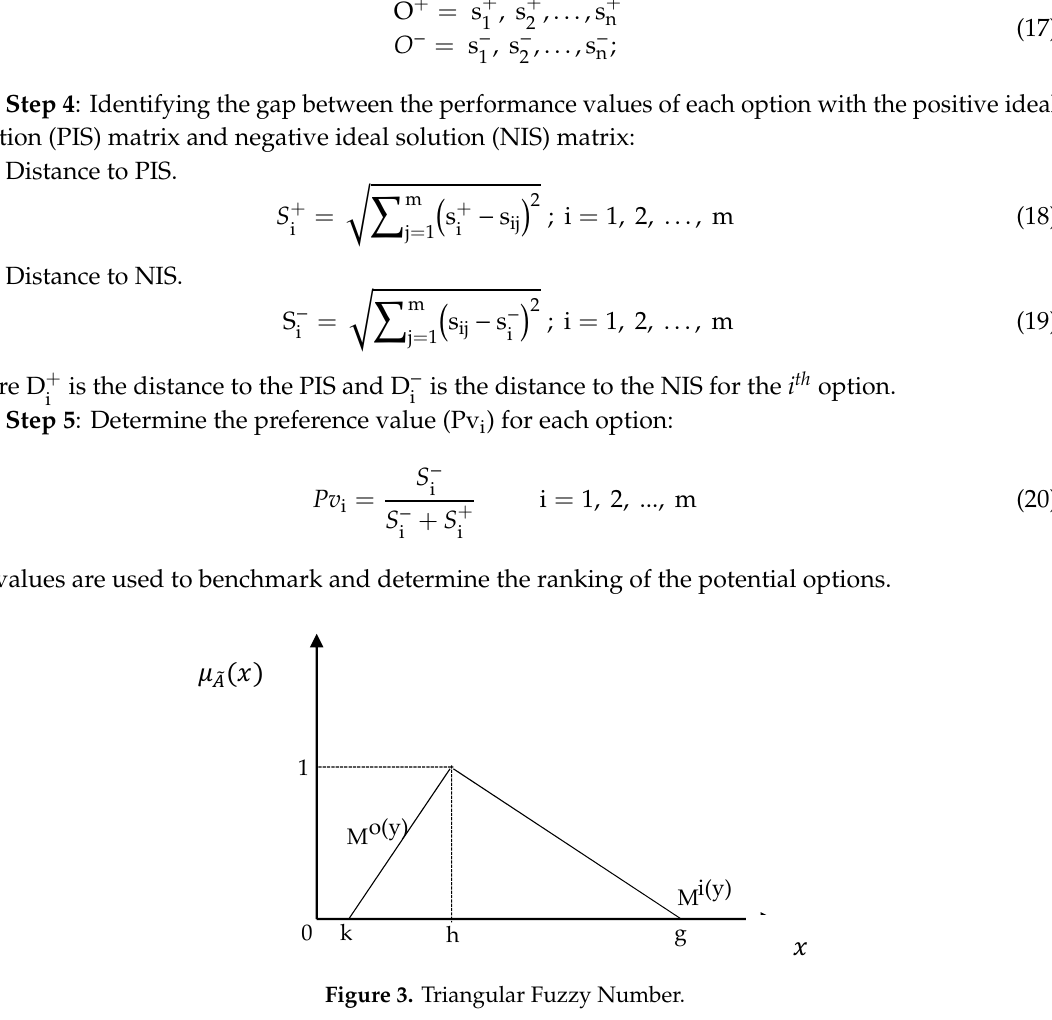
Figure 3. Triangular Fuzzy Number.